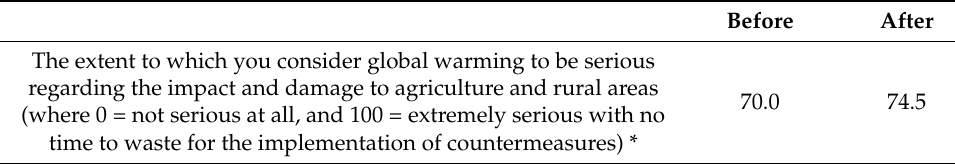
Table 5. Realization of the climate change impacts.